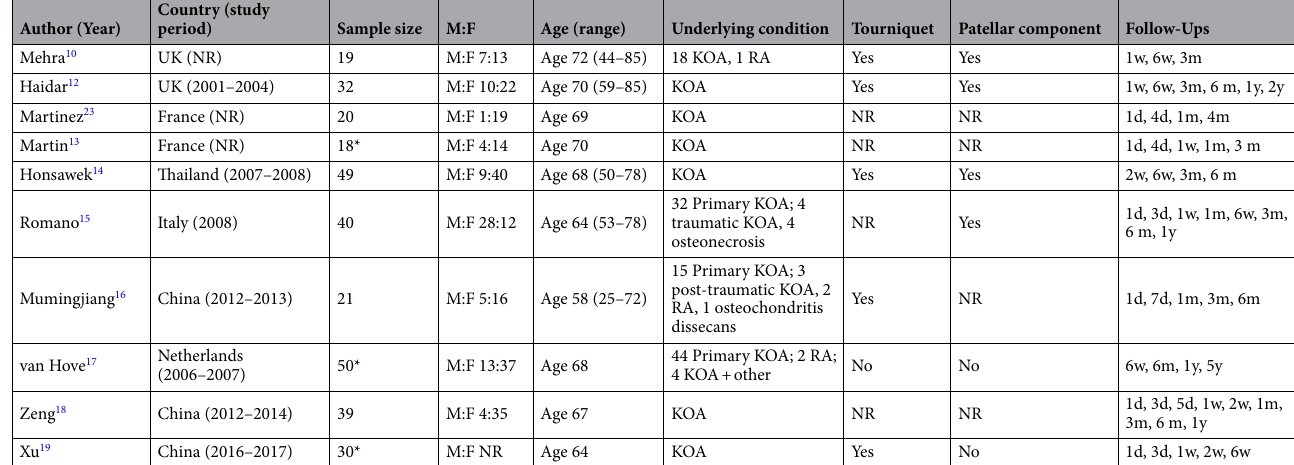
Table 1. Characteristics of Studies Included in the Meta-Analysis. *Data from RCT control group; M:F, Male:Female counts; Age, mean [year old]; NR, not reported; d, day; w, week; m, month; y,